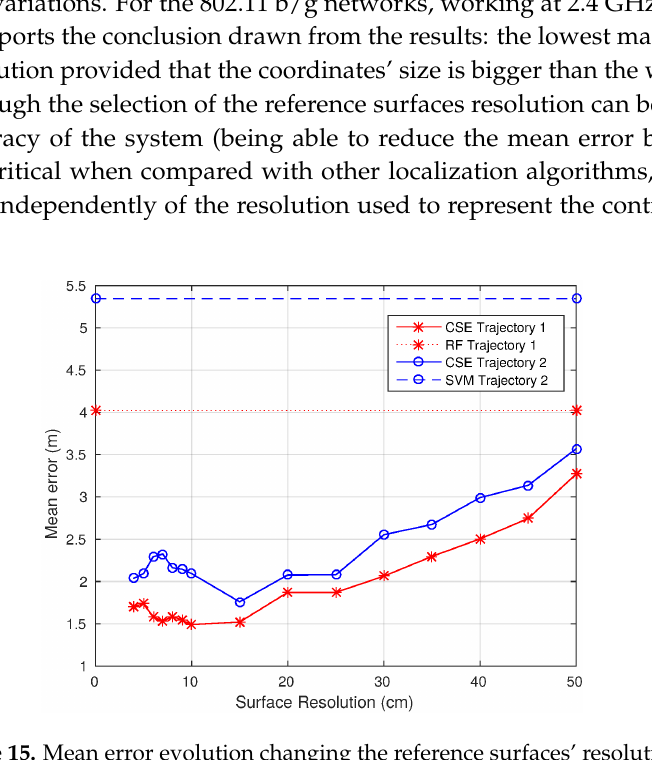
Figure 15. Mean error evolution changing the reference surfaces’